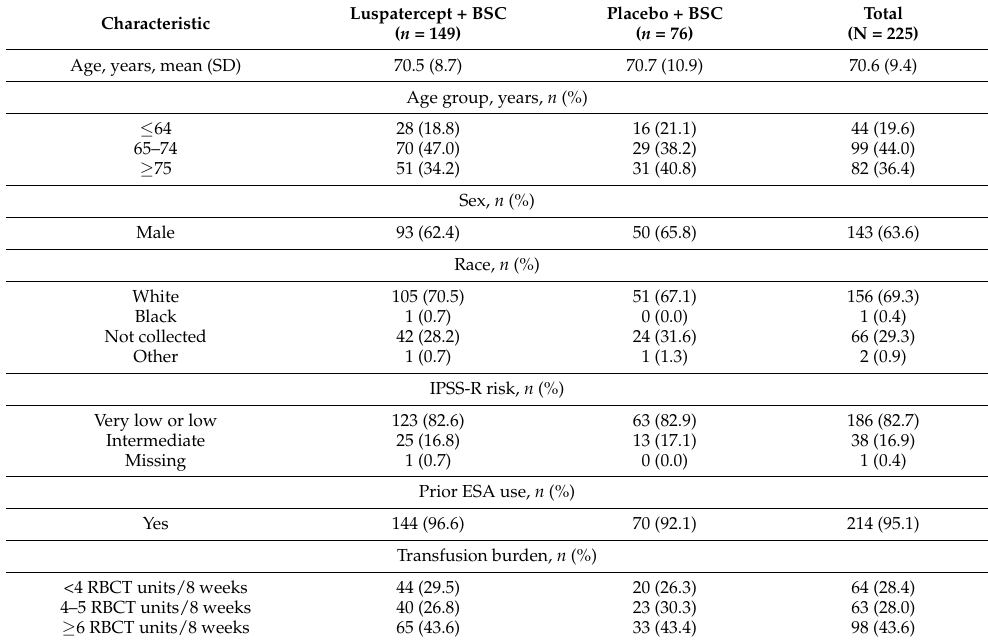
Table 1. Patient demographics and clinical characteristics at baseline of HRQoL-evaluable population.